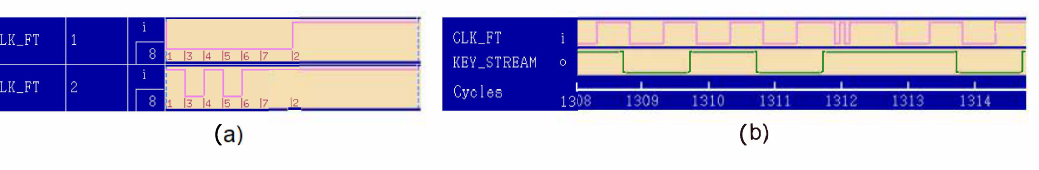
Figure 5. Screen capture of: ( a ) waveforms to be applied, ( b ) clock signal with the short pulse. Table 3. Number of fault injected in the cipher per clock cycle and fault